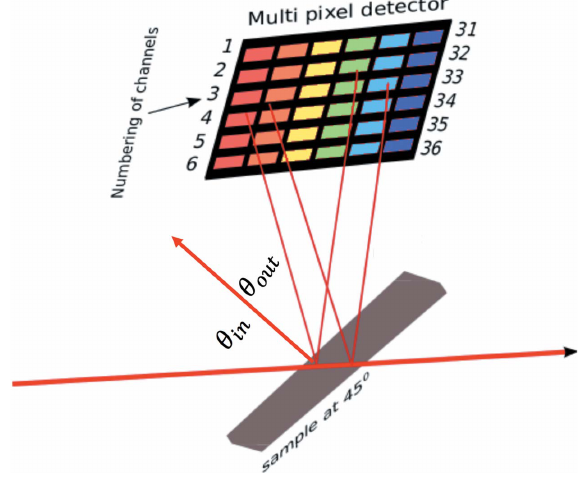
Figure 3 A schematic diagram of the fluorescence detector geometry.